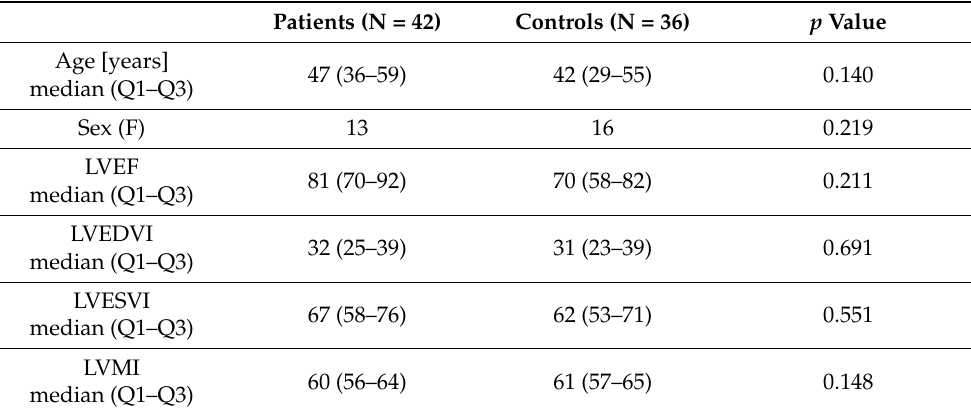
Table 1. Demographic and clinical characteristics of the study group. Data are presented as median